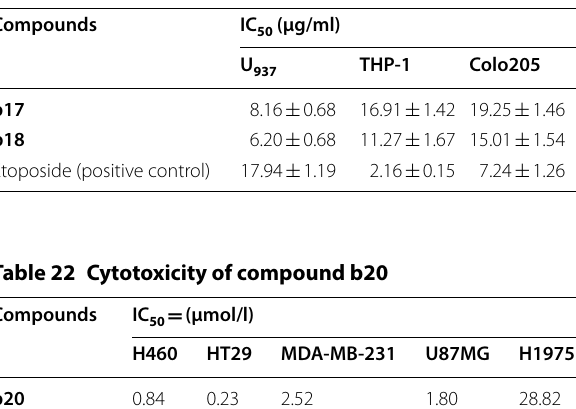
Table 21 In vitro cytotoxicity of pyrido[2,3- d ]pyrimidine derivatives against U , THP-1 and Colo205 cancer cell 937 lines